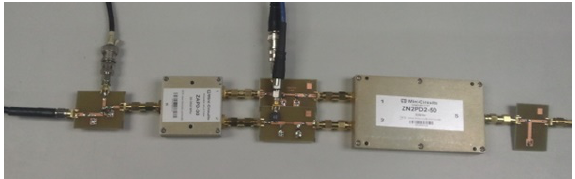
Figure 12: Photo of the ptoposed Radar